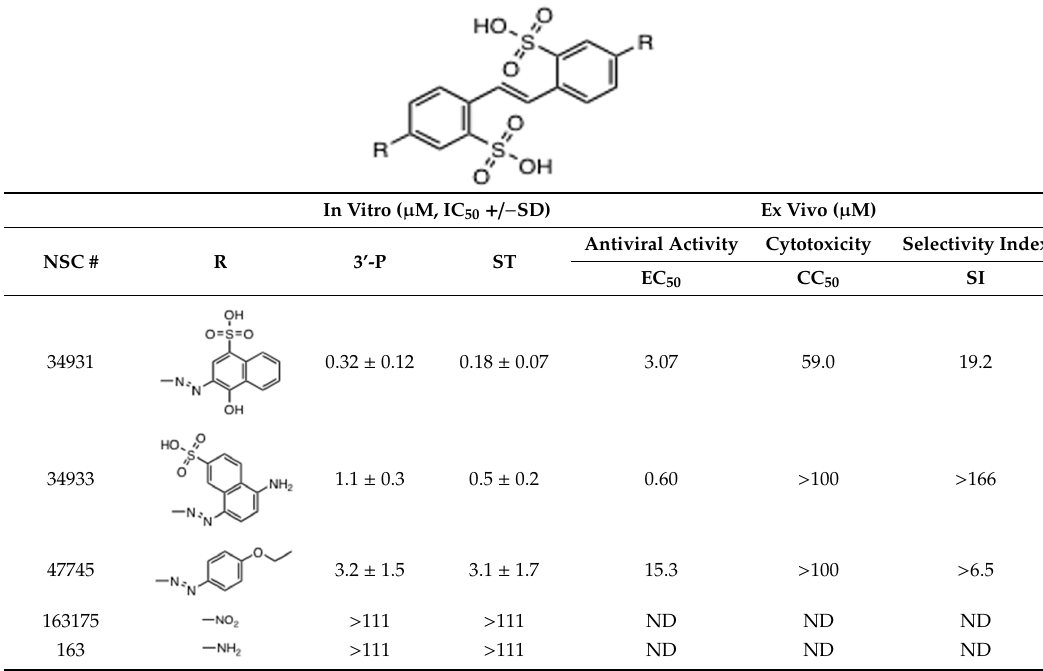
Table 1. Summary of stilbene disulfonic acid derivatives activities. IN-catalyzed 3 ′ -P and ST were monitored using a gel-based assay. IN-catalyzed 3 ′ -P corresponds to the cleavage of the terminal dinucleotide at the 3 ′ -end of the viral DNA mimic, while ST corresponds to the integration of the 3 ′ -P product within another DNA molecule. Values derived from at least three independent experiments.